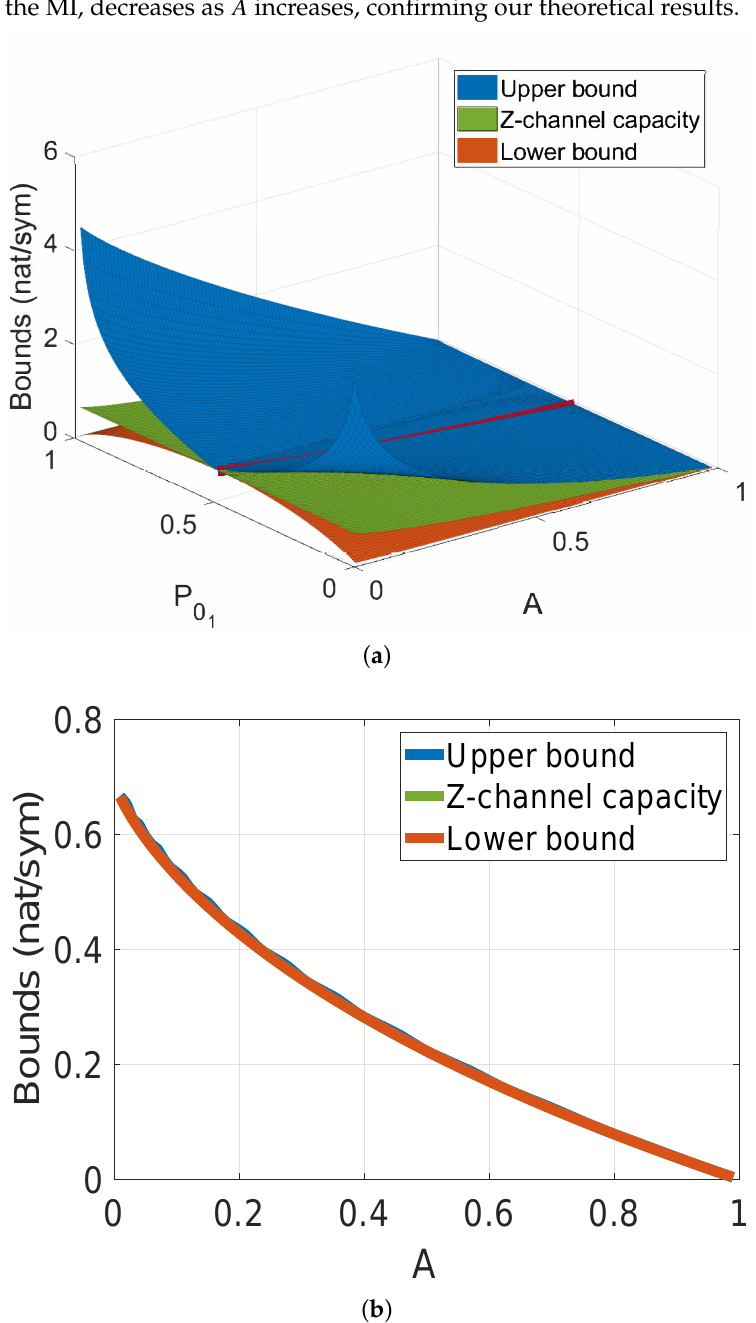
Figure 4. ( a ) Upper, lower bounds on the channel capacity, and Z-channel capacity for the four signaling systems, by varying 𝑃 0 and 𝐴 . ( b ) Channel capacity bounds and Z-Channel capacity with 1 respect to the valid range of 𝐴